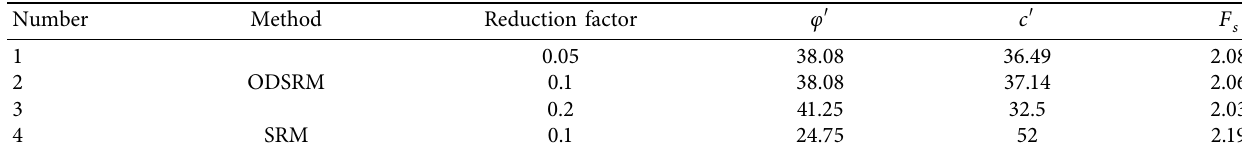
Table 7: Safety factors under various reduction